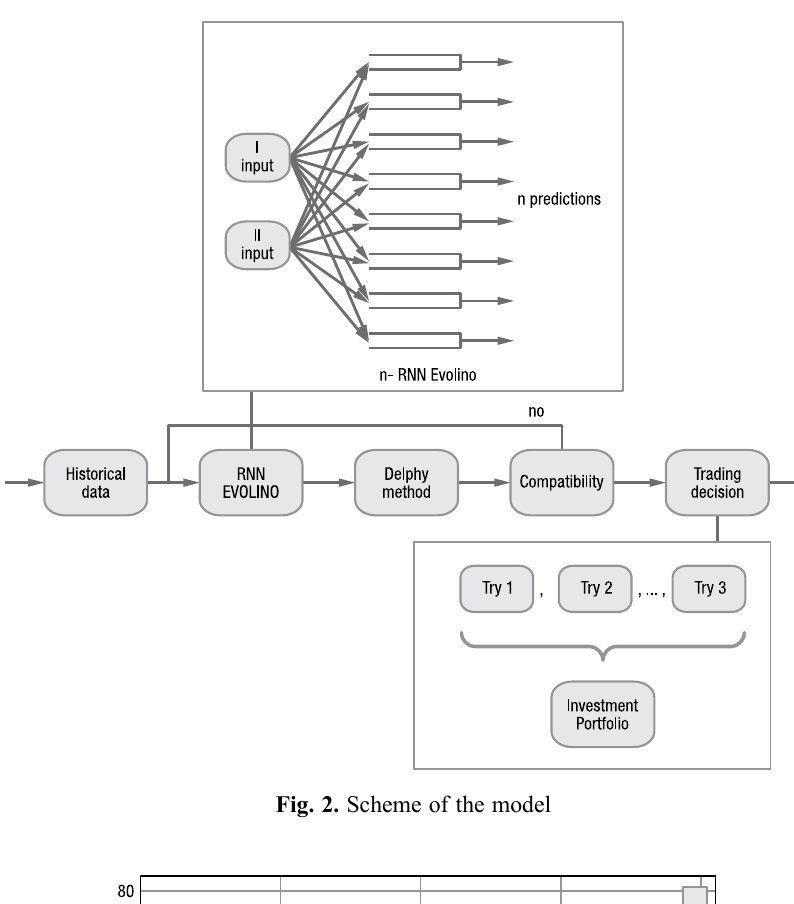
Fig. 2. Scheme of the model